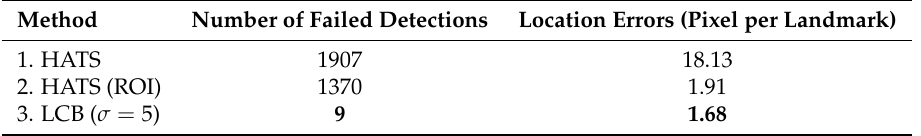
Table 1. Performance comparison of histogram-based adaptive thresholding (HATS) and LCB